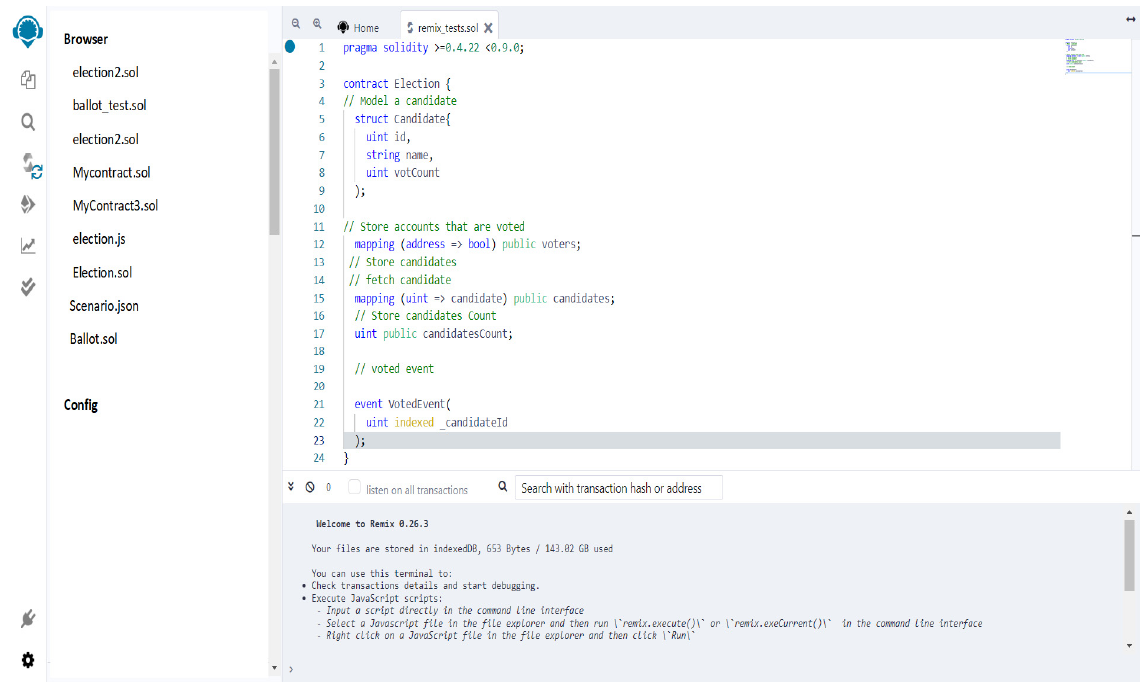
Figure 6. Ethereum Blockchain.